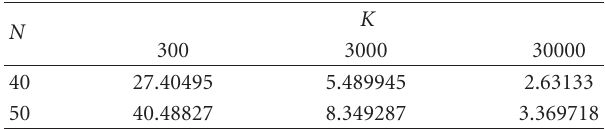
Table 2: D rms s corresponding to K s and N s.